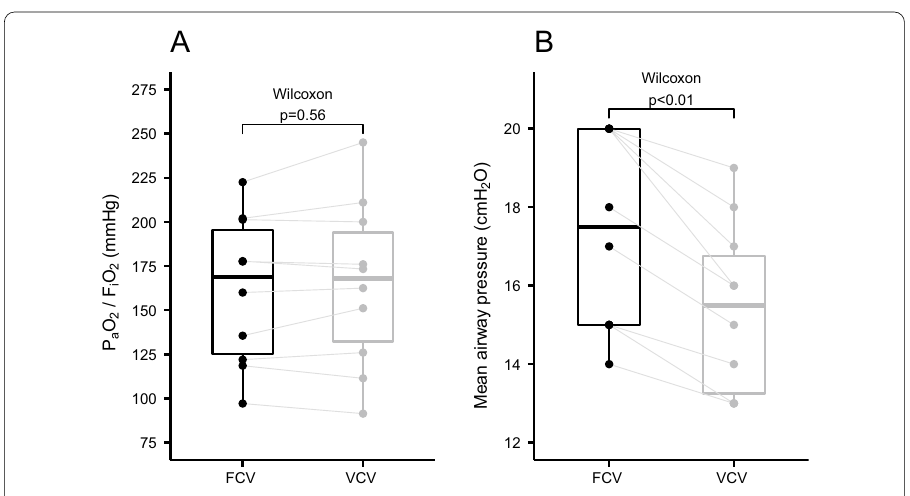
Fig. 2 Boxplots of P a O 2 /F I O 2 ratio ( A ) and mean airway pressure ( B ) during FCV and VCV. Identical subjects are connected with grey lines. Groups were compared with the paired Wilcoxon signed-rank test. FIO2 fraction of inspired oxygen, FCV flow-controlled ventilation, PaO2 arterial partial pressure of oxygen, VCV volume-controlled